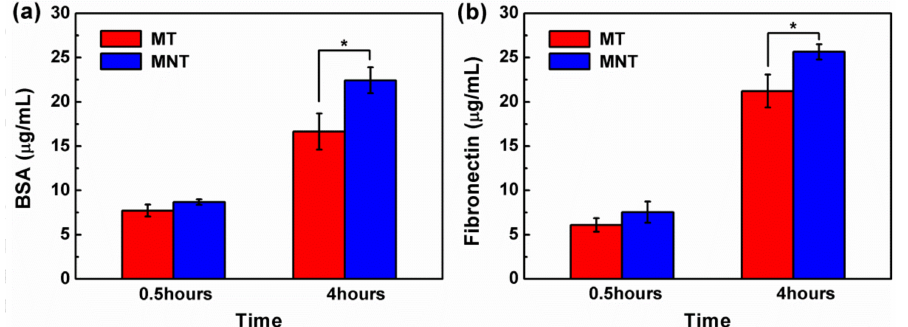
Figure 8. Protein adsorption on MT and MNT surface after incubation for 0.5, 4 h (bovine serum albumin (BSA) ( a ); and fibronectin (Fn) ( b )). (* represents p <